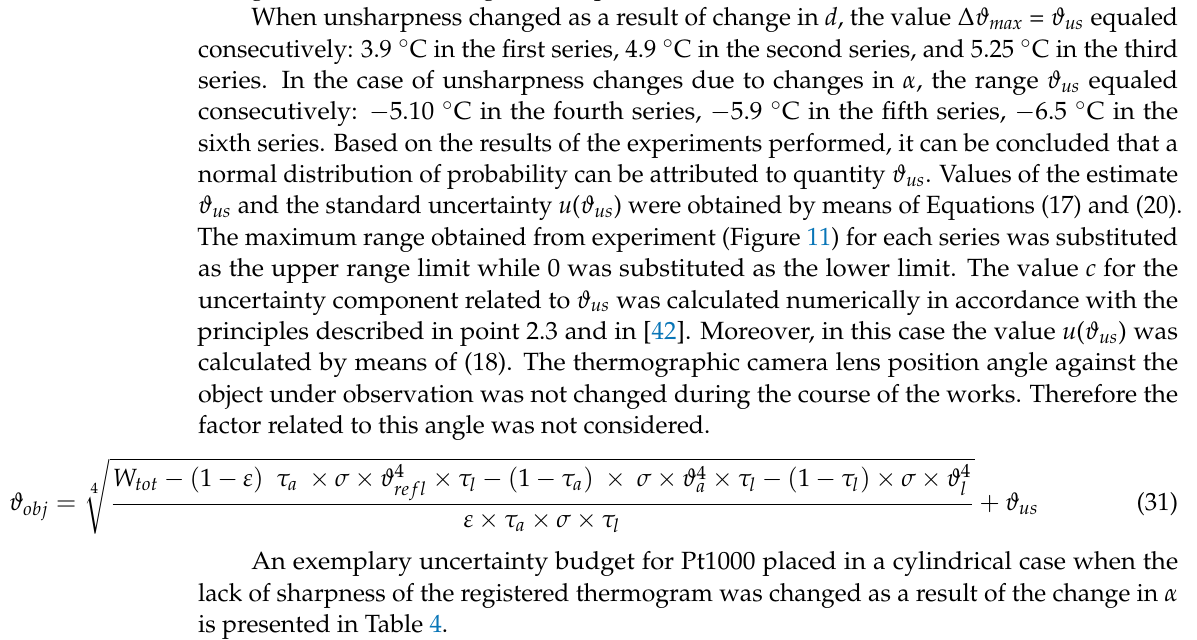
Table 4. Major uncertainty budget determined for the quantity ϑ obj considering ϑ us for Pt1000 in a cylindrical case. Change of unsharpness by the change of α for series 3. The standard uncertainty value is in the bottom right corner.